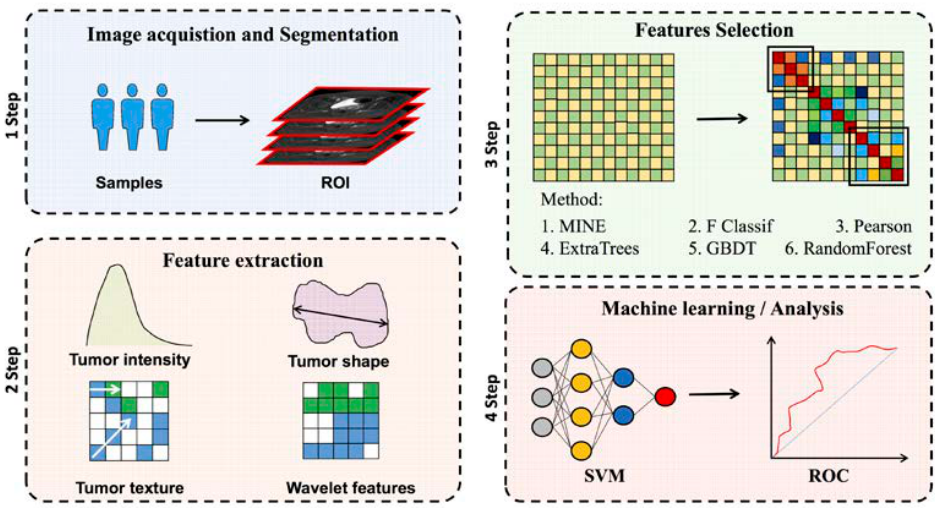
Figure 3. Radiomics analysis workflow. The study’s subject underwent T2WI image collection.